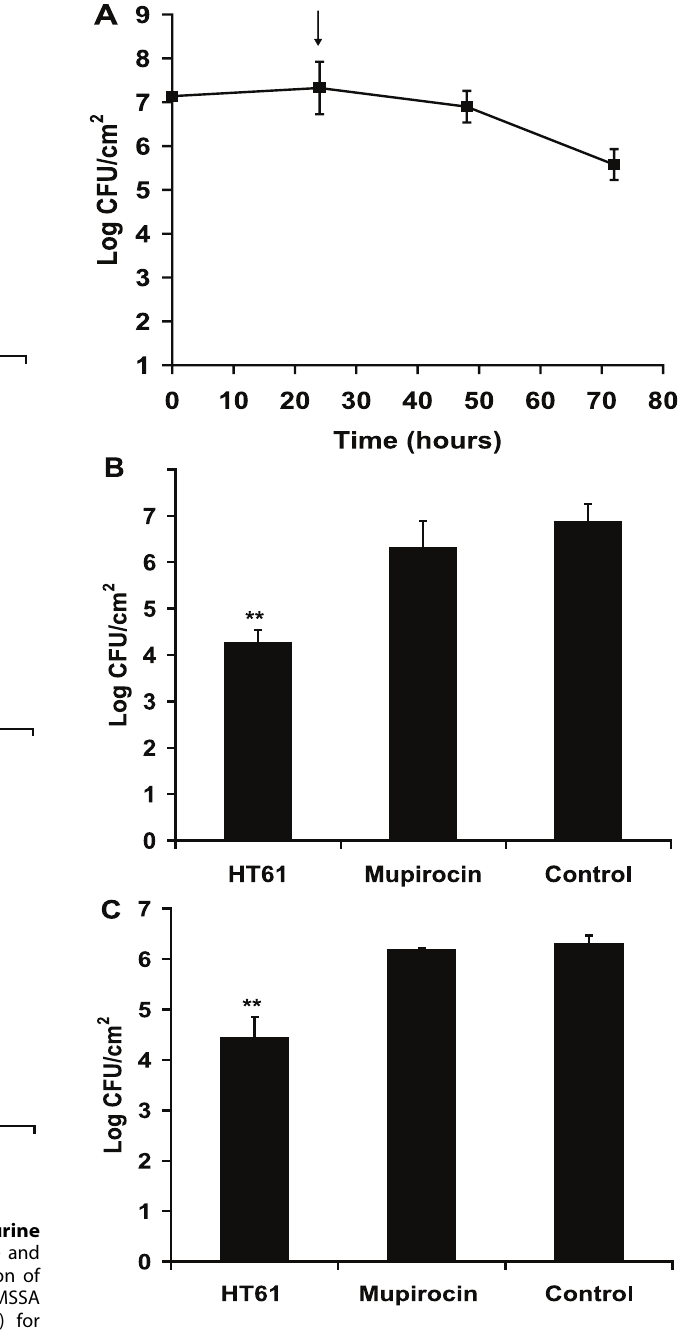
skin bacterial infection model. A. After tape-stripping the skin, log phase MSSA was applied onto the skin area. At different time points CFU counts of the bacteria were determined. The arrow indicates the point which the treatment was initiated. B. Treatment of HT61, Bactroban and placebo (control) against MSSA and C. Treatment of HT61, Bactroban and placebo (control) against MRSA. **, P , 0.01. The data has been repeated